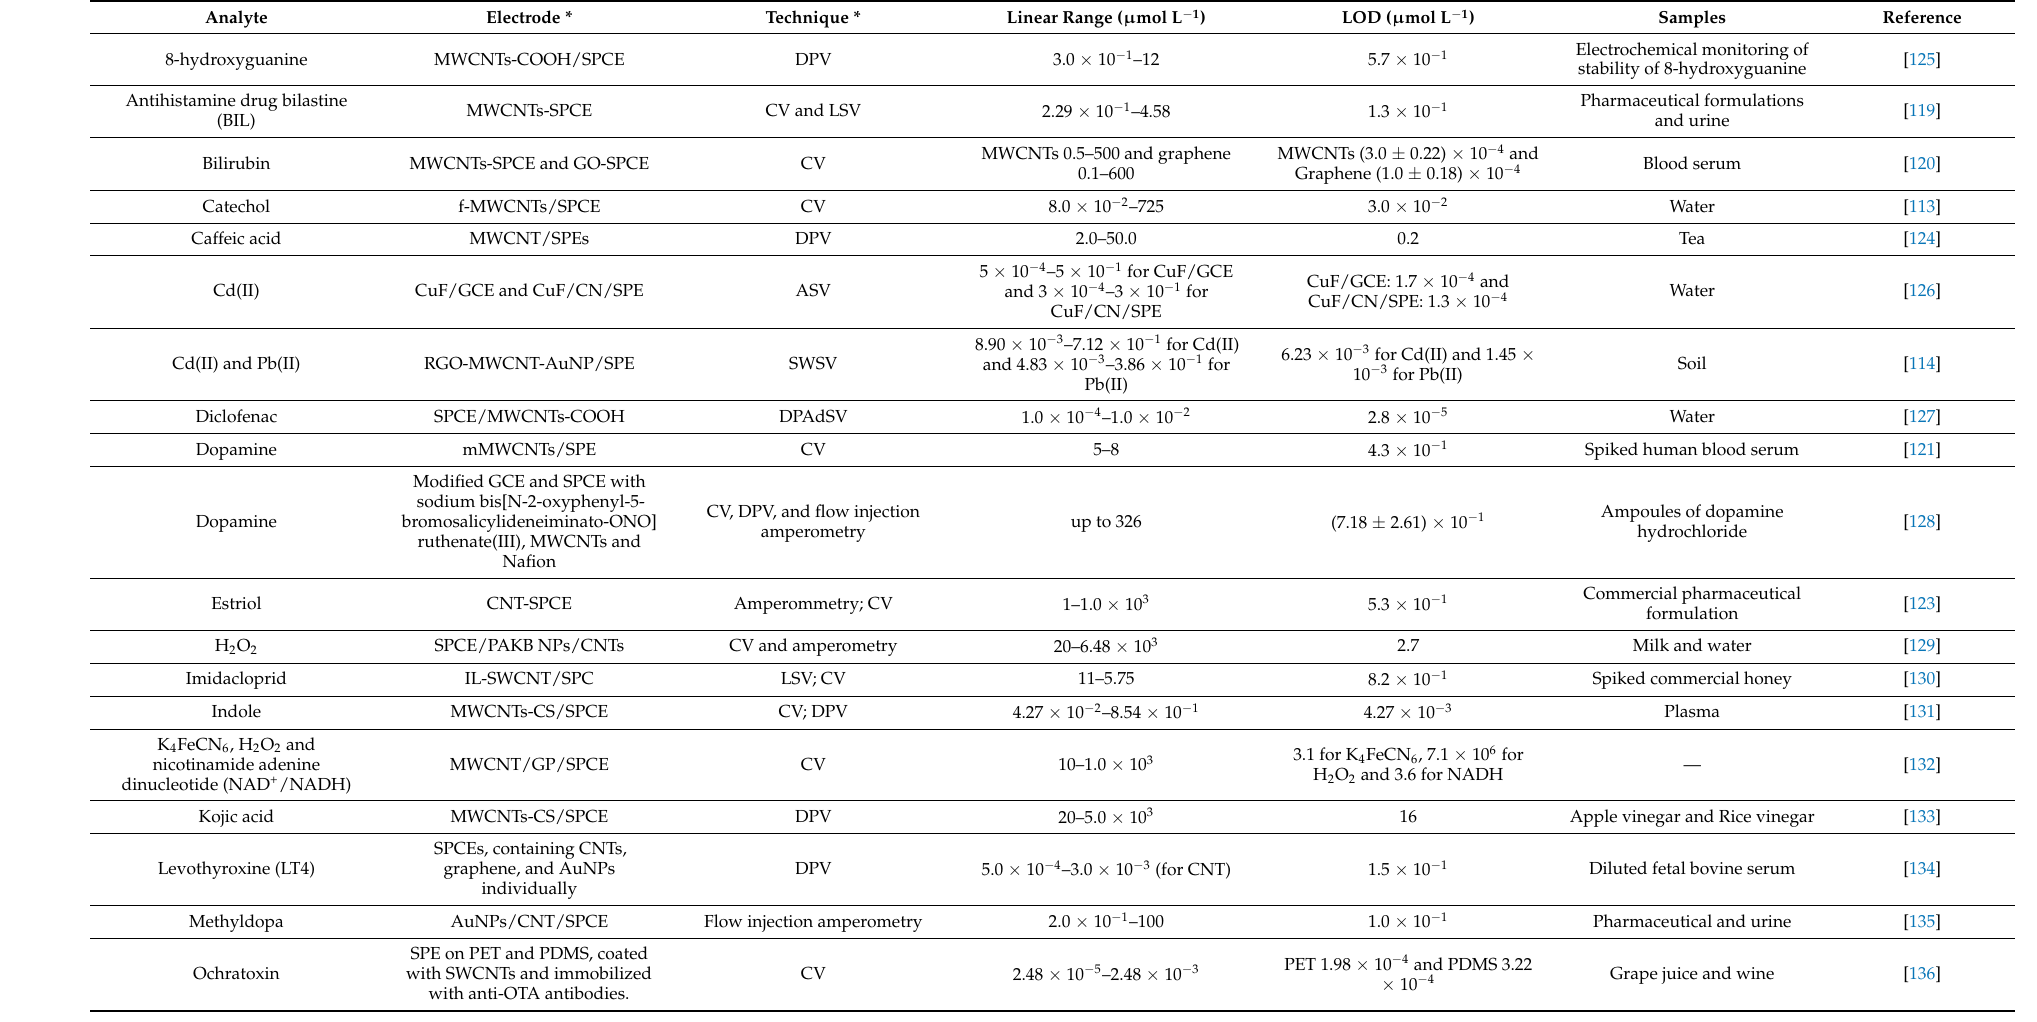
Table 2. Electrochemical sensors based on carbon nanotubes